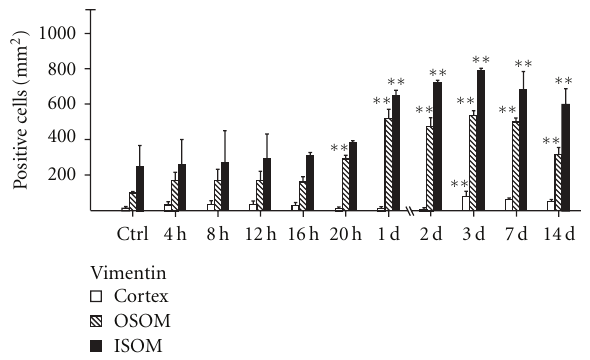
Figure 3: Distribution of vimentin immunoreactivity in the renal interstitium from controls (Ctrl) or from animals sacrificed at increasing time intervals (hours or days) after reperfusion. Each col- umn corresponds to the mean number of vimentin immunoreactive fusiform cells ( ± SD) after examination of cortex and outer medulla (OSOM, ISOM) for each experimental group ( n = 4) ( ∗∗ P < . 01 versus control).